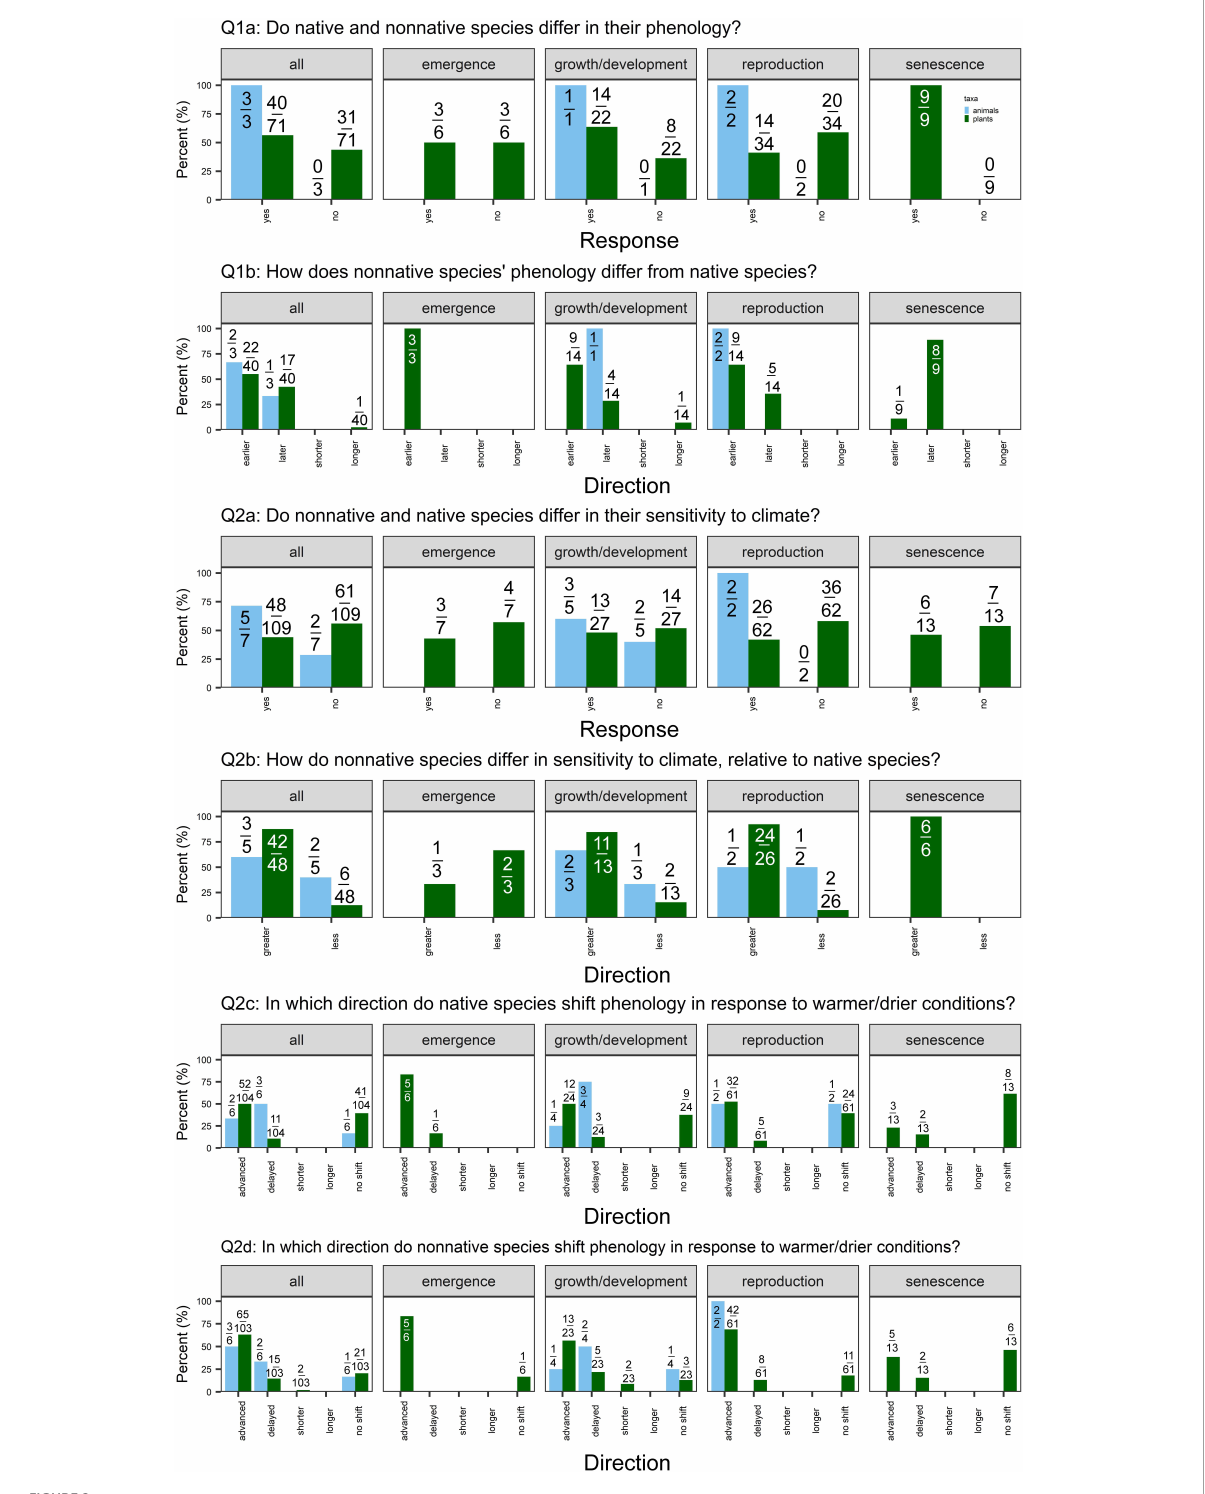
FIGURE2 Percent of cases supporting or contradicting each of the questions outlined for all phenophases, emergence, growth and development, reproduction, and senescence (left to right), split by taxa [light blue = animals (7 cases total; 5 insects, 1 bird, and 1 tunicate); green = plants ( n = 109 cases)]. Values are the number of different responses for each question out of the total number of cases that addressed that question. (Q1a) We examine whether native and non-native species differ in their mean phenology. “Yes” indicates that studies detected a